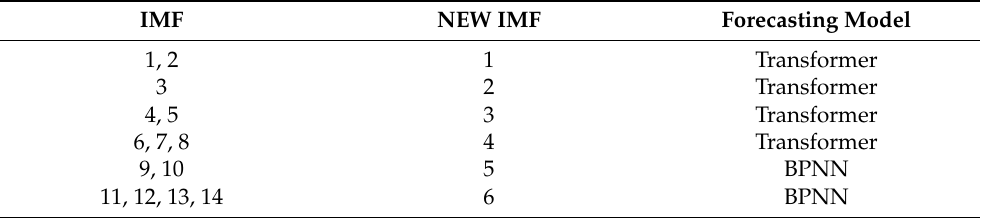
Table 2. Recombined results of each component. IMF NEW